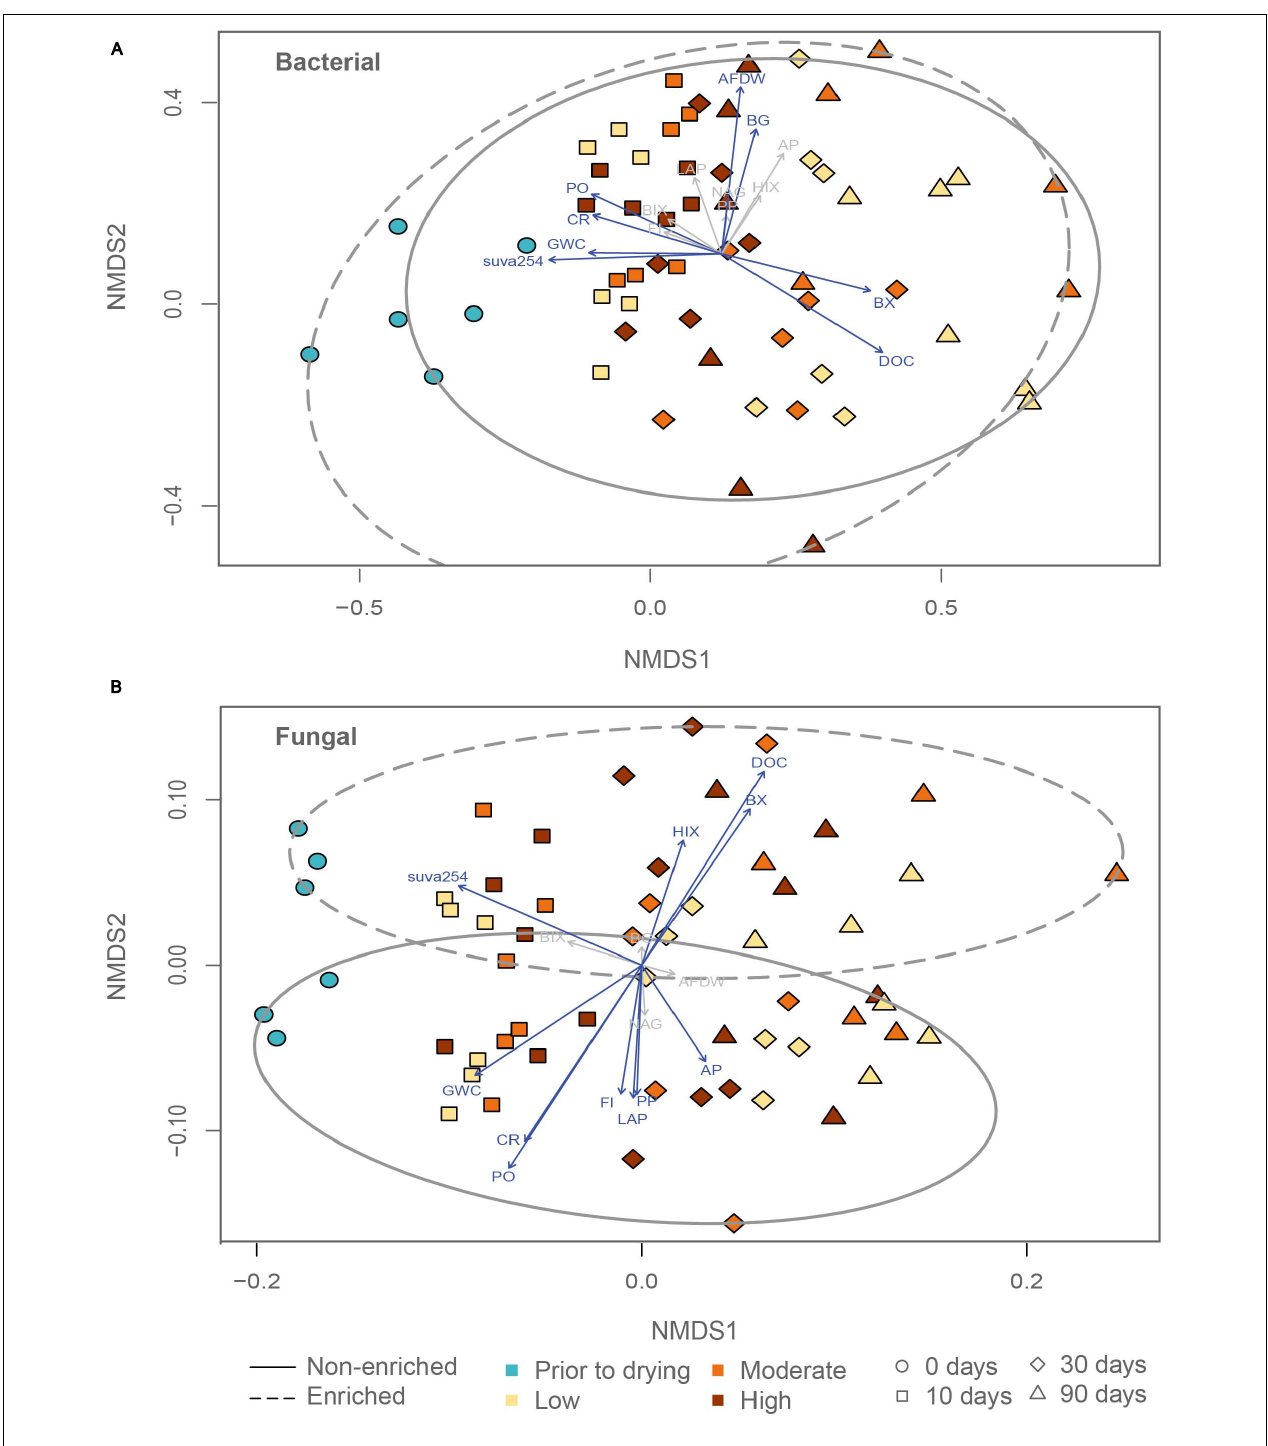
FIGURE 2 | Non-metric multidimensional scaling ordination (nMDS) of (A) bacterial and (B) fungal communities in relation to a suite of environmental variables linked to organic matter content (ash free dry weight ( AFDW ), dissolve organic carbon ( DOC ), fluorescence index ( FI ), humification index ( HIX ), biological index ( BIX ), and suva254 ), sediment gravimetric water content ( GWC ), and all microbial functions tested (community respiration ( CR ), β -glucosidase ( BG ), β -xylosidase ( BX ), phenol peroxidase ( PP ), phenol oxidase ( PO ), alkaline phosphatase ( AP ), chitinase ( NAG ) and leucine aminopeptidase ( LAP )).